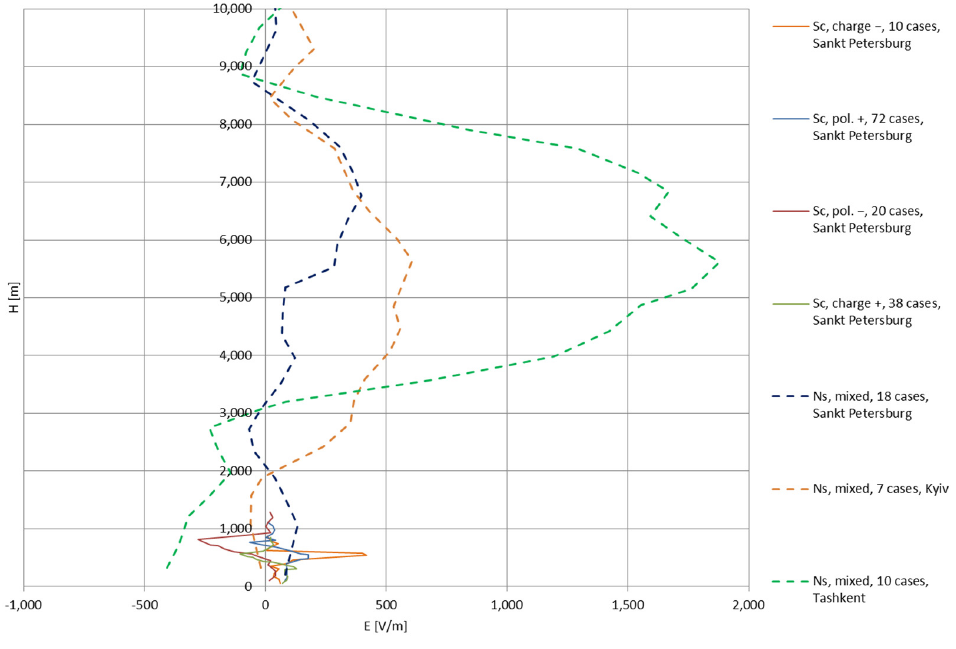
Figure 3. The electric field strengths measured for different types of cloud polarizations (data based on [17]).